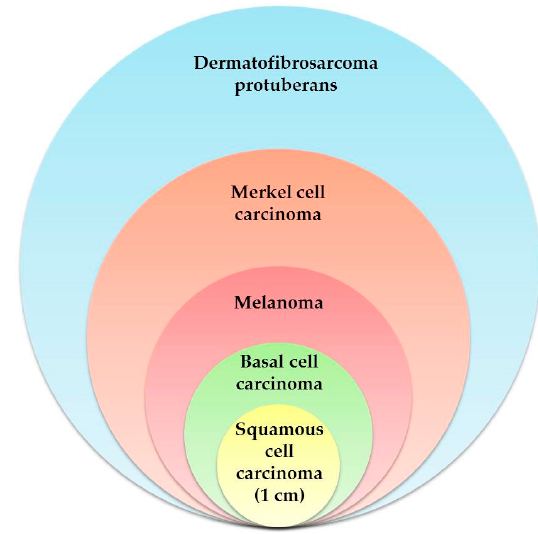
Figure 4. The relative size of peripheral margins in the removal of various types of skin cancer.